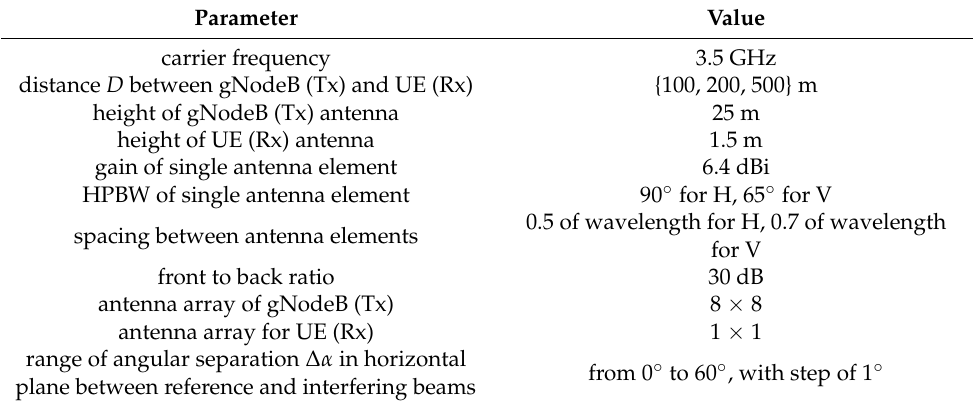
Table 1. Main simulation